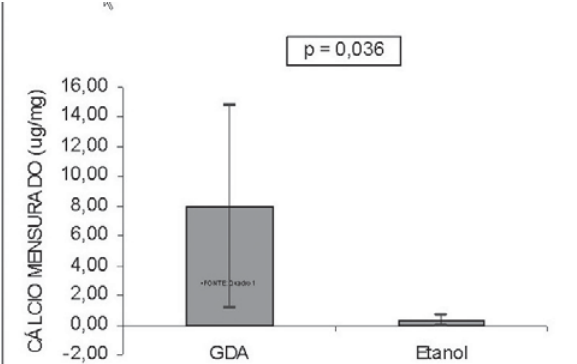
Fig. 7 - Mensuração do cálcio na cúspide do heteroenxerto valvar pulmonar porcino, nos grupos de estudo - 210 dias (Média com desvio padrão)